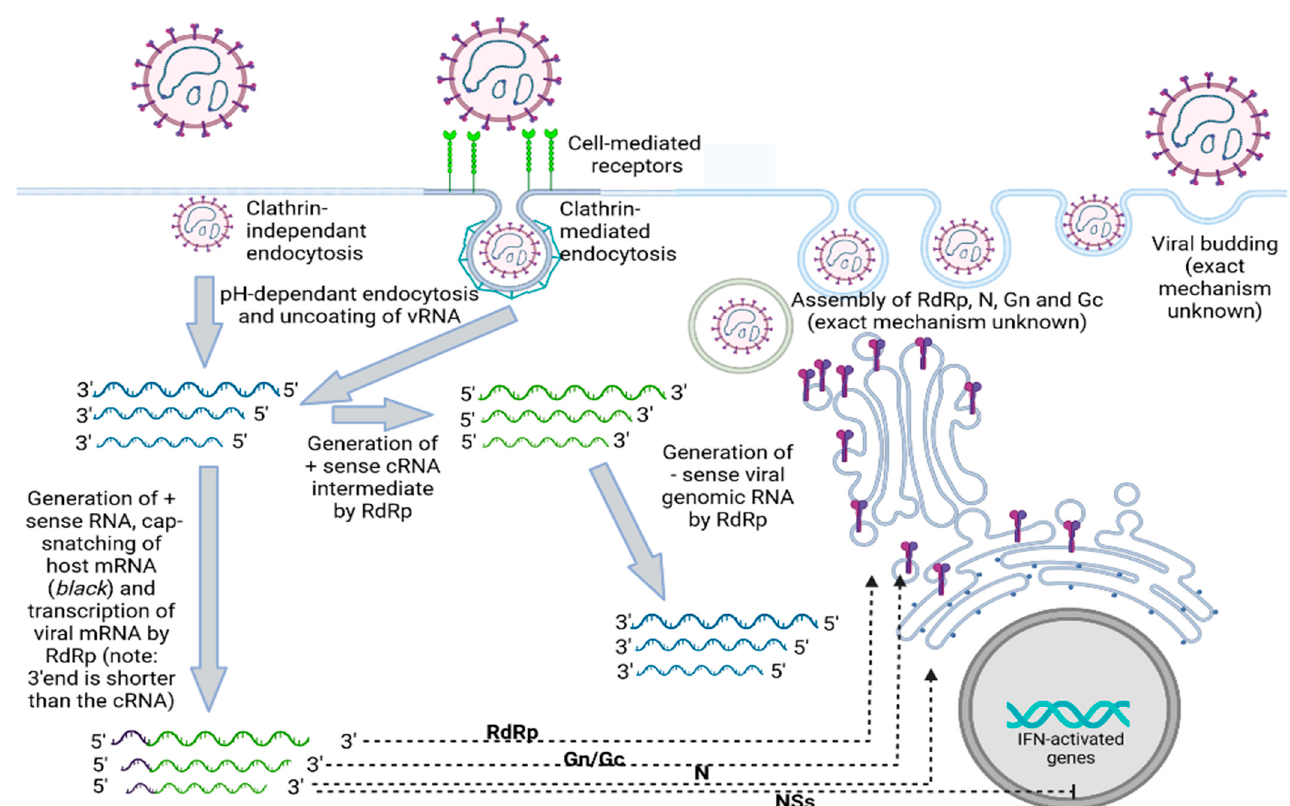
Figure 1. Schematic of our current understanding of the replication cycle of a typical bunyavirus. Bunyaviruses may be able to infect a cell either through receptor-mediated endocytosis (which may involve clathrin) or through clathrin-independent endocytosis. Upon viral entry, uncoating of the virion results in the presentation of multi-segmented ( − ) sense RNA in the host cytoplasm. An RNA-dependent RNA polymerase (RdRp) from the infectious particle enables the replication of the viral genome into a positive sense RNA intermediate. A “cap-snatching” mechanism enables the attachment of 5 ′ host mRNA, resulting in translatable viral mRNA. Translation of the viral mRNA results in the synthesis of all the components of an infectious virus (i.e., glycoprotein N, glycoprotein C, nucleoprotein, and RdRp) as well as up to two non-structural proteins, NSs and NSm. NSs has been shown to be capable of inhibiting the transcription of interferon-induced genes. The (+) sense intermediate RNA can also serve as a template for genomic replication by the RdRp into ( − ) sense genomic RNA. The figure was generated using icons and templates from Biorender.com.